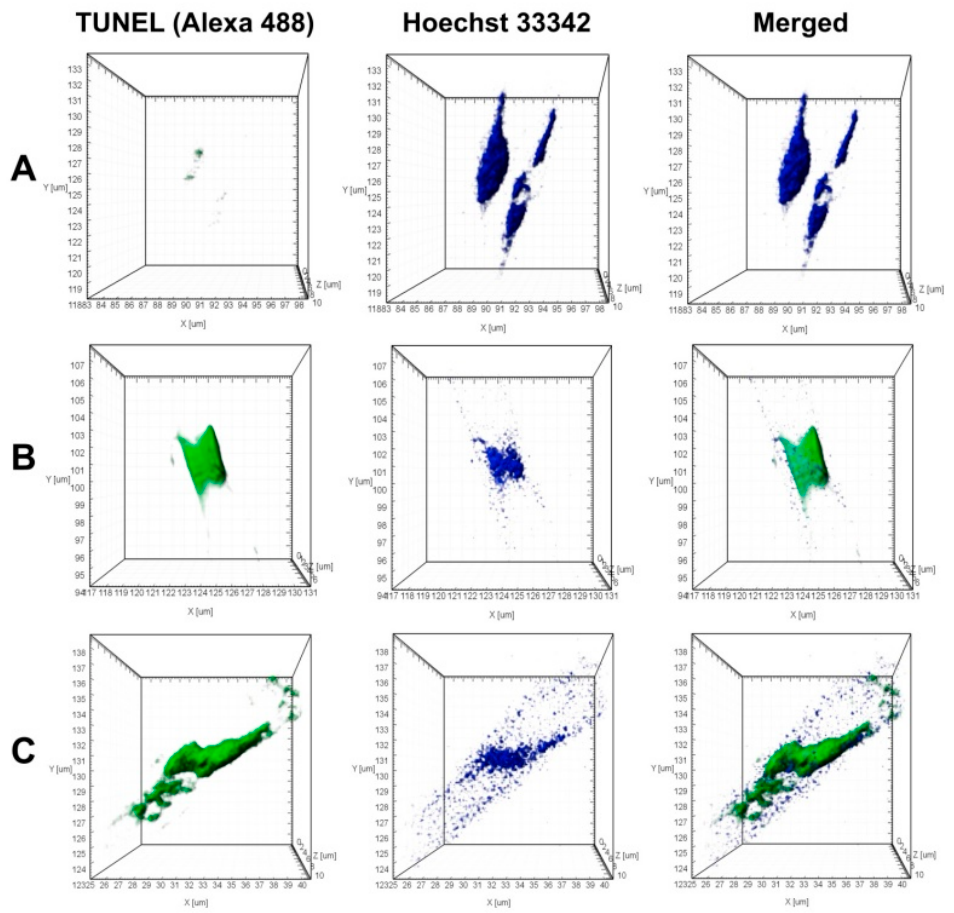
Figure 7. Fragmentation of nuclear DNA (Click-iT™ TUNEL Alexa Fluor™ 488 Imaging Assay) in U. acus cells induced by culturing with B. mycoides BS2-15 bacterial culture. Staining for fragmented DNA (Click-iT™ TUNEL Alexa Fluor™ 488, green) and for nuclei (Hoechst 33342, blue); laser confocal microscopy; 3D reconstructions. ( A ) axenic U. acus ; ( B ) TUNEL positive control (axenic U. acus treated with DNAse I to model DNA breakage); ( C ) experiment (culturing with B. mycoides BS2-15 bacterial culture for 24 h).